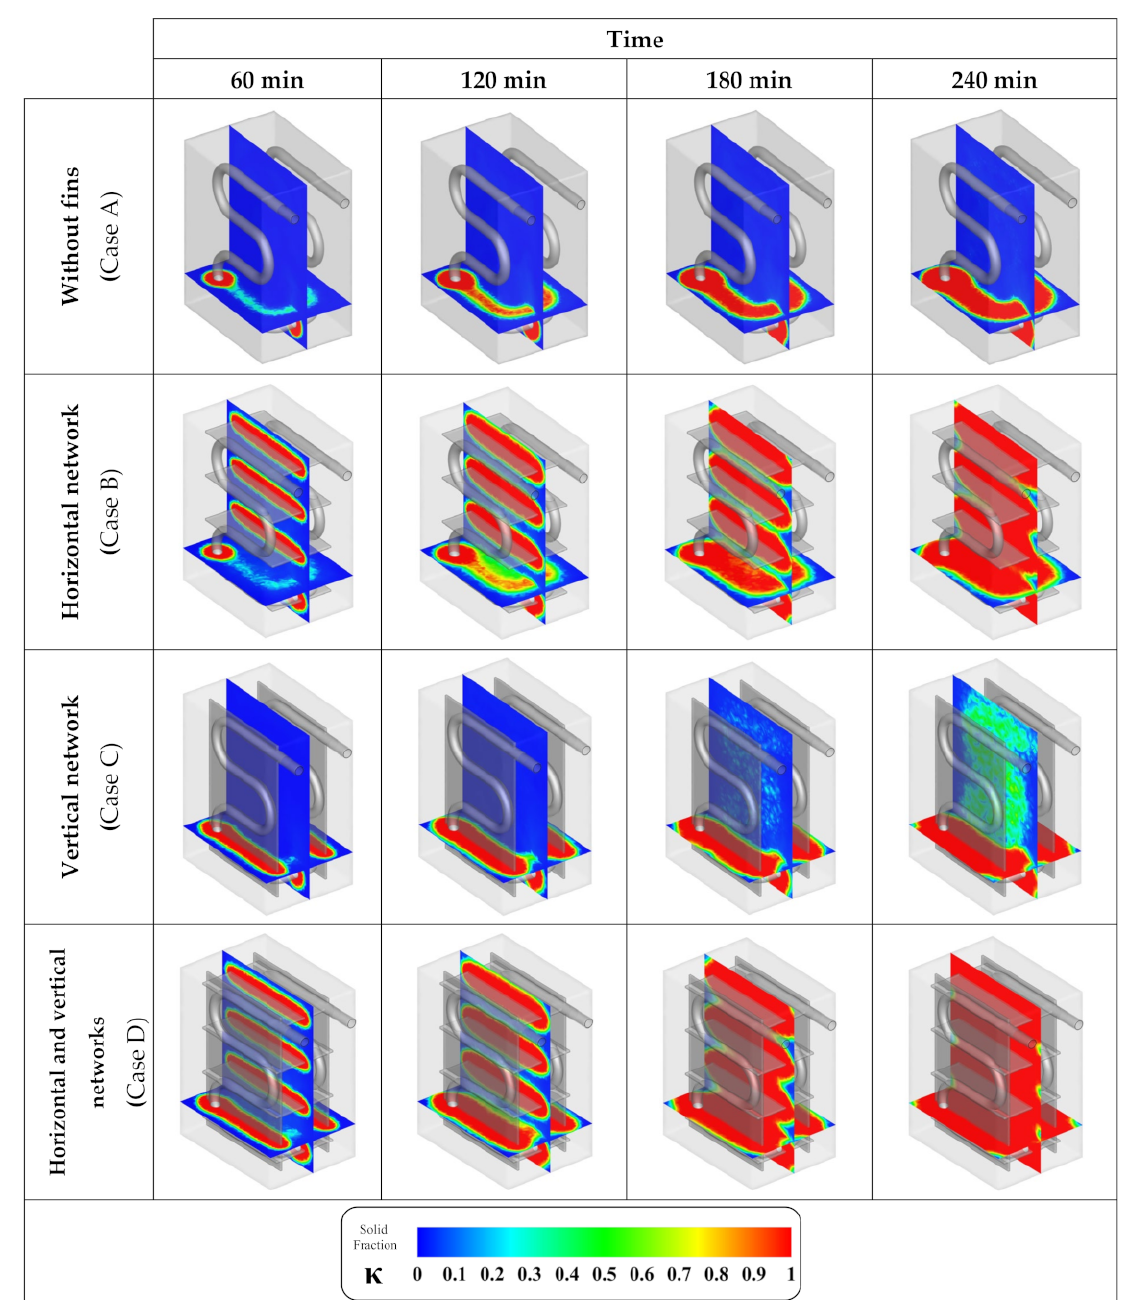
Figure 7. Contours of solid fraction advancement with various plate-fin